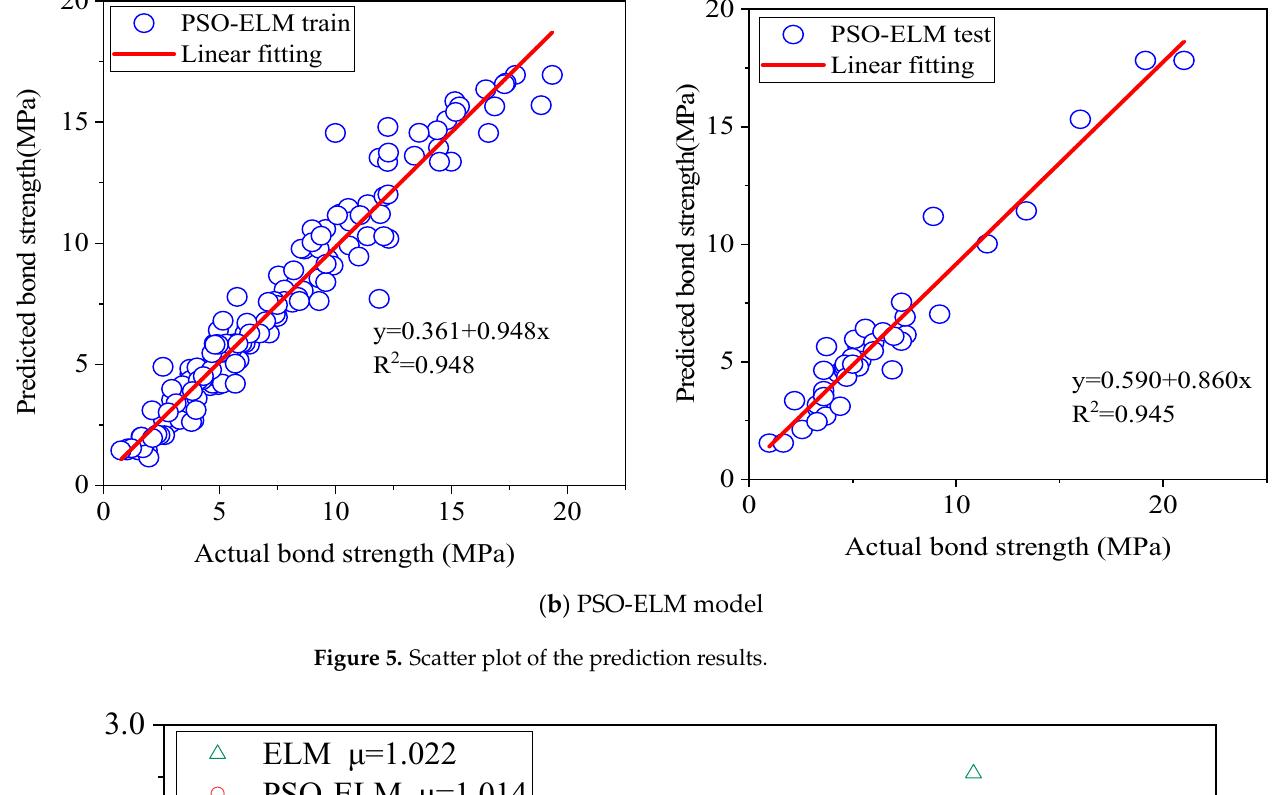
Figure 5. Scatter plot of the prediction results. Figure 6 also displays the proportion between the two models’ actual bond strengths and their projected values. The mean value of 1.014 for the PSO-ELM model is closer to one than the mean value of 1.022 for the ELM model. The PSO algorithm’s optimization improved the model’s capability for making predictions. When assessing the effectiveness of a prediction, the relative error is frequently more important than the absolute mistake. The relative prediction error of the models for the training and test phases is shown in Figure 7 and Table 2. The mean value of the relative error for the PSO-ELM model was lower for both the training and testing stages. Table 3 lists the five evaluation metrics in- troduced in this paper. Compared to the error statistics MSE, RMSE, and MAE of 1.549, 1.244, and 0.883 with the pre-optimization model for the test set, the optimized model achieved the smaller MSE, RMSE, and MAE of 1.170, 1.082, and 0.777, respectively. For the training set, the average relative error was reduced from 14.714% to 11.655%, and the average relative error was reduced from 15.590% to 13.953% for the test set, which further indicates that the PSO-ELM model’s predictability was indeed improved after optimiza- tion.